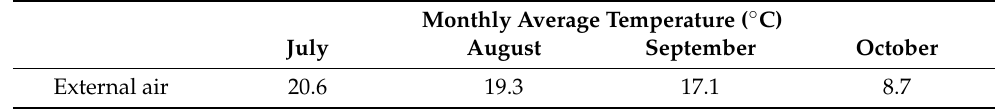
Table 2. Properties of materials.